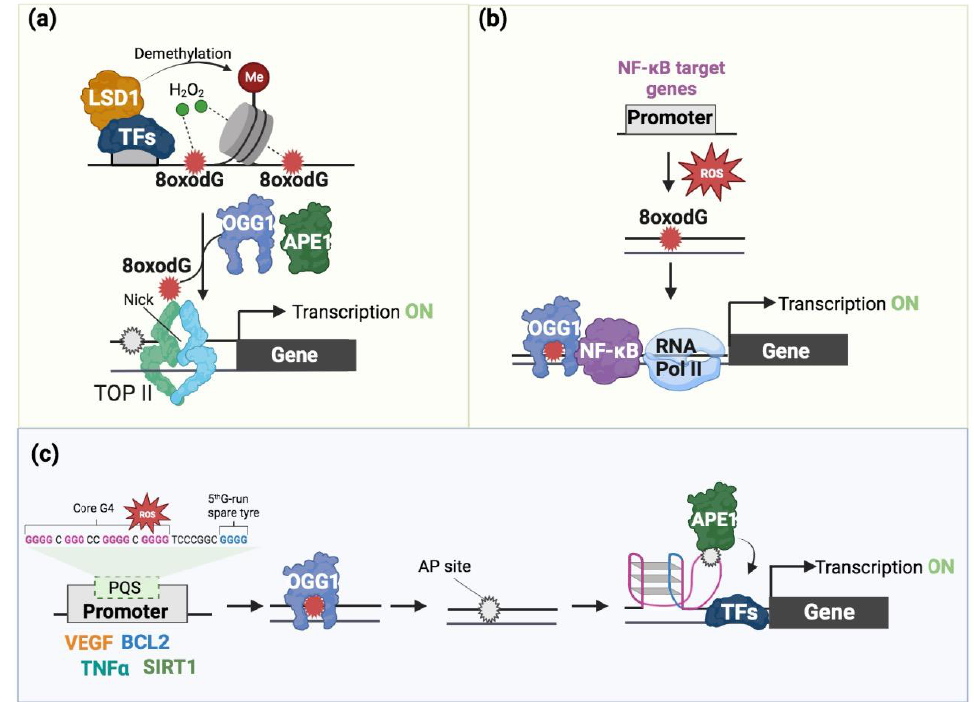
Figure 3. Epigenetic role of 8-oxodG. ( a ) A specific TF recruits LSD1 demethylases to its target genes. Local ROS (H2O2), produced by LSD1 during the histone demethylation reaction, results in the formation of 8-oxodG. 8-oxodG is then converted in an AP site via OGG1 and subsequently in a nick via APE1. The nick allows the entry of the Topoisomerase II and of the RNA polymerase II machinery to activate the transcription of downstream genes. ( b ) The signaling pathway activated by ligands (such as TNF) produces ROS which induce 8-oxodG formation close to NF-kB binding sites. 8-oxodG promotes the recruitment of the OGG1-NF-kB complex, thus activating the transcription of downstream genes. ( c ) “Spare tire” model. ROS promotes the formation of 8-oxodG (red) in the PQS-containing promoter of specific genes (VEGF, BCL2, etc.); the PQS has a fifth extra run of guanines (indicated in blue) in addition to the typical four G runs (indicated in pink). OGG1 is recruited and promotes the AP site (gray) formation as an intermediate of the 8-oxodG-repair process. The AP-containing region is then extruded into a loop, and the fifth extra G run stabilizes an alternative G4 structure formation. Then, APE1 binds to the AP site into the extruded loop and, independently of its endonuclease activity, promotes the recruitment of various TFs to activate the transcription of downstream